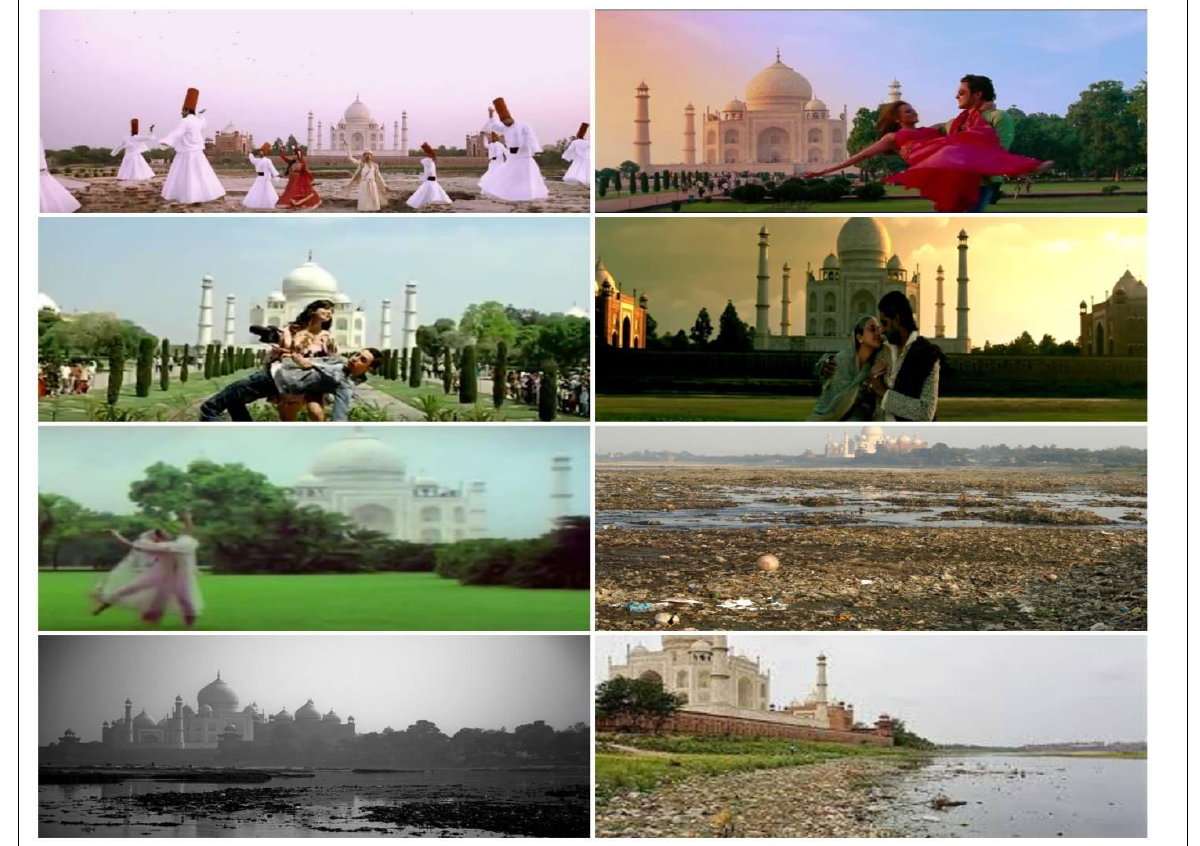
Picture 3: Images of Taj Mahal in Bollywood movies vis- à -vis its real images. (Source: